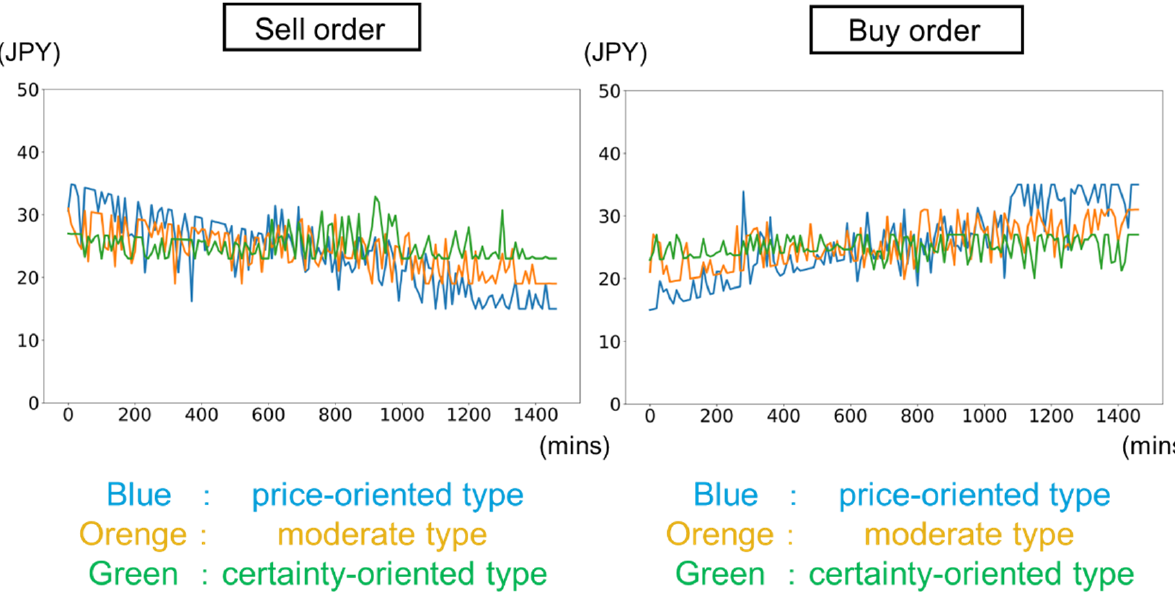
Figure A1. The base bidding price (price without a random term).